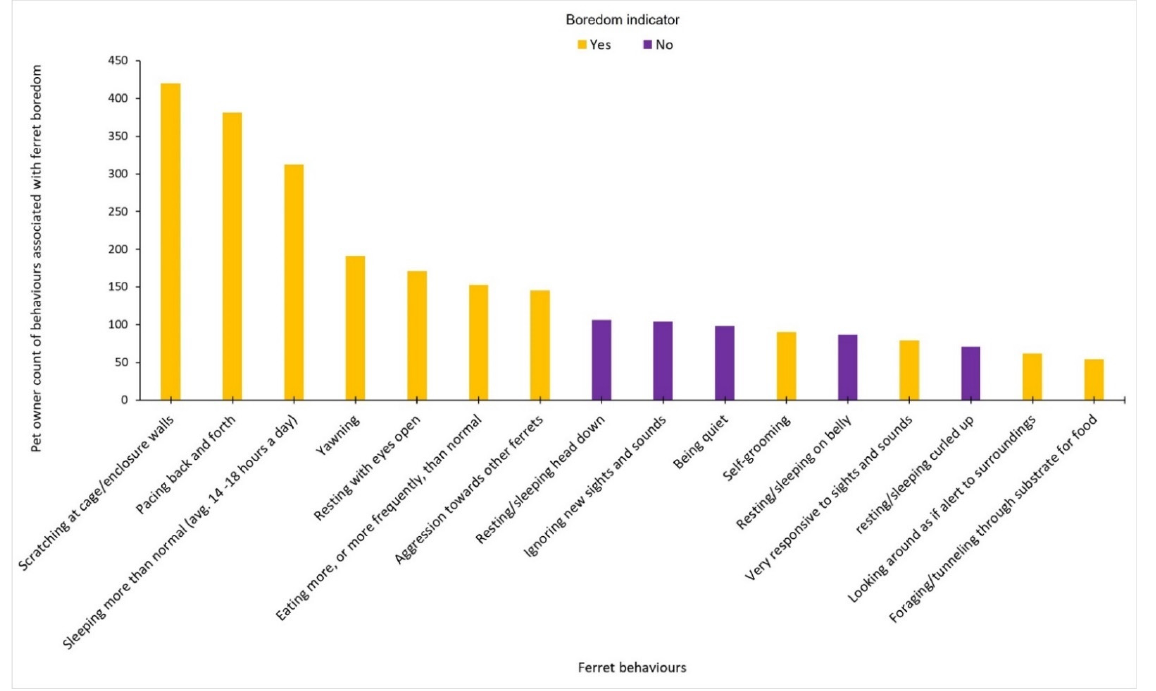
Figure 3. Behaviours that pet ferret owners associate with ferret boredom. Only behaviours selected by n > 50 respondents were included. Behaviours that are identified in the literature as being potential indicators of boredom are shown in gold, and those that are not potential indicators of boredom are shown in purple. Pet owners were not made aware of which behaviours were gold standard indicators of boredom.